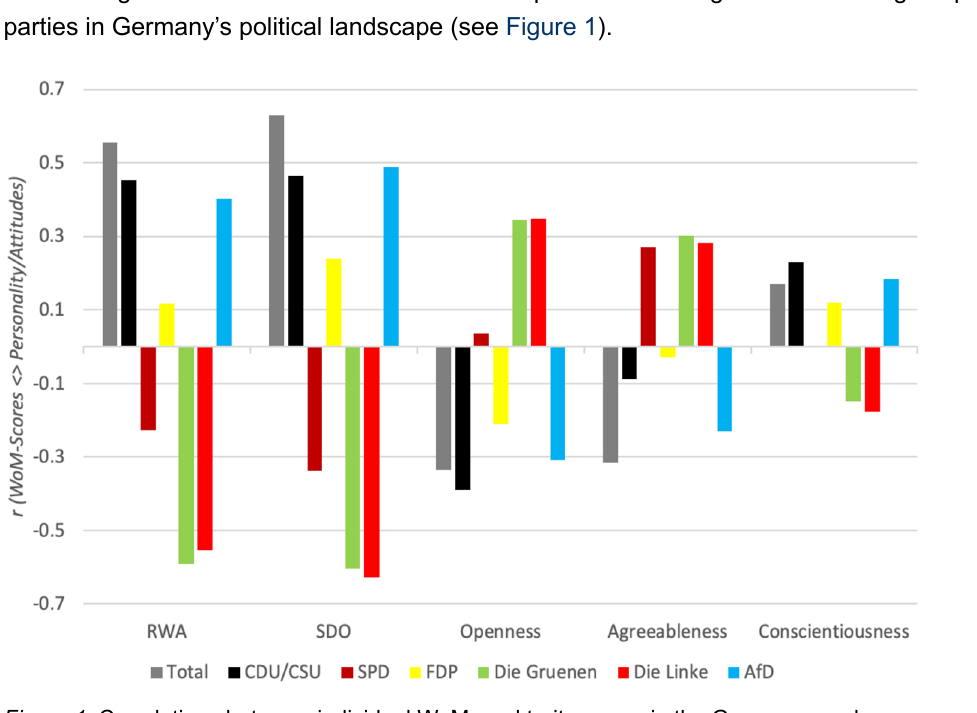
Figure 1. Correlations between individual WoM- and trait- scores in the German sample. * p < .05. ** p < .01. *** p <